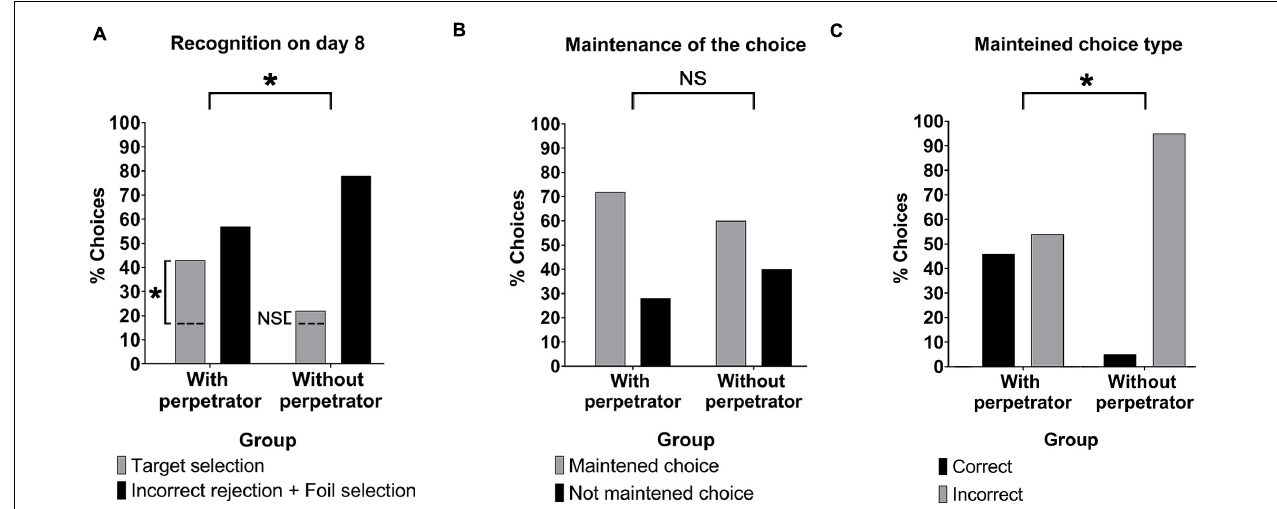
FIGURE 2 | Lineup recognition. (A) Percentage of target selection and incorrect rejection + foil selection for the With perpetrator and Without perpetrator groups on day 8. With perpetrator group: target selection ( N = 17), incorrect rejection ( N = 0), and foil selection ( N = 22). Without perpetrator group: target selection ( N = 7), incorrect rejection ( N = 1), and foil selection ( N = 25). (B) Percentage of maintained and not maintained choices between day 2 and 8 for the With perpetrator and Without perpetrator groups. With perpetrator group: maintained choices ( N = 28), not maintained choices ( N = 11). Without perpetrator group: maintained choices ( N = 20) and not maintained choices ( N = 13). (C) Percentage of correct and incorrect maintained choices. With perpetrator group: correct (target selection/target selection, N = 12); incorrect (incorrect rejection/foil selection, N = 4 and foil selection/foil selection, N = 17). Without perpetrator group: correct (correct rejection/target selection, N = 1); incorrect (foil selection/foil selection, N = 24). The following choices were not present in the sample: incorrect rejection/incorrect rejection (for the With perpetrator group) and correct rejection/target selection and foil selection/incorrect rejection (for Without perpetrator group). * p < 0.05; NS, p > 0.05. The dashed lines stand for the chance level (17% of correct